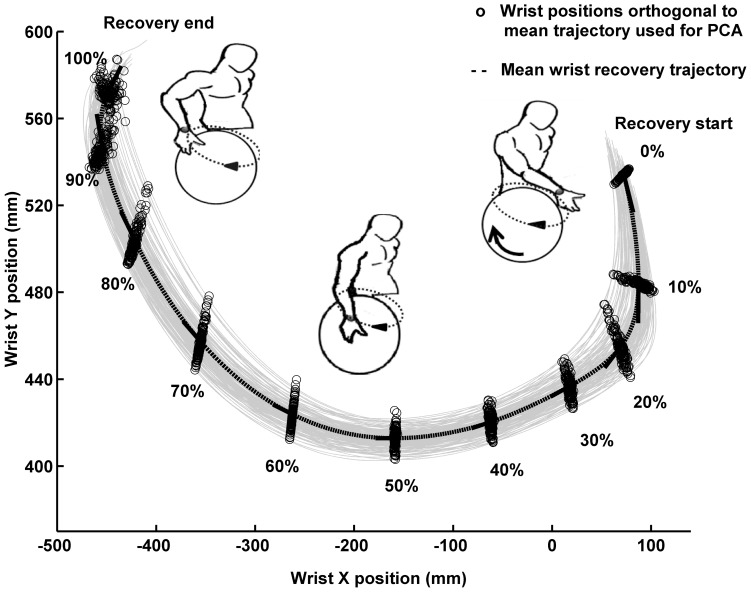
Sample steady-state wrist recovery trajectories for a semi-circular propulsion pattern.Wrist cycle-to-cycle recovery trajectories (“grey solid lines”) for a participant with shoulder pain during a three minute trial at fast speed (1.11(.05) m/s). The mean wrist recovery trajectory is shown by the bold dashed line at center (“- -”). The wrist positions orthogonal to mean recovery trajectory for which PCA was computed (0% to 100% at every 10% interval along the recovery path) is denoted by (“o”).